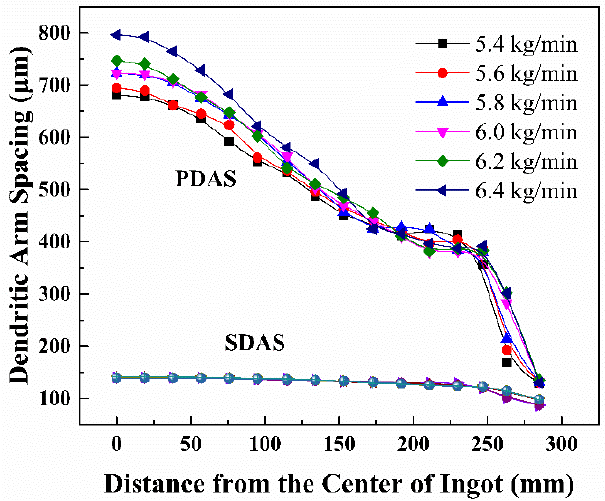
Figure 7. The effect of melting rate on the size of dendrite spacing.